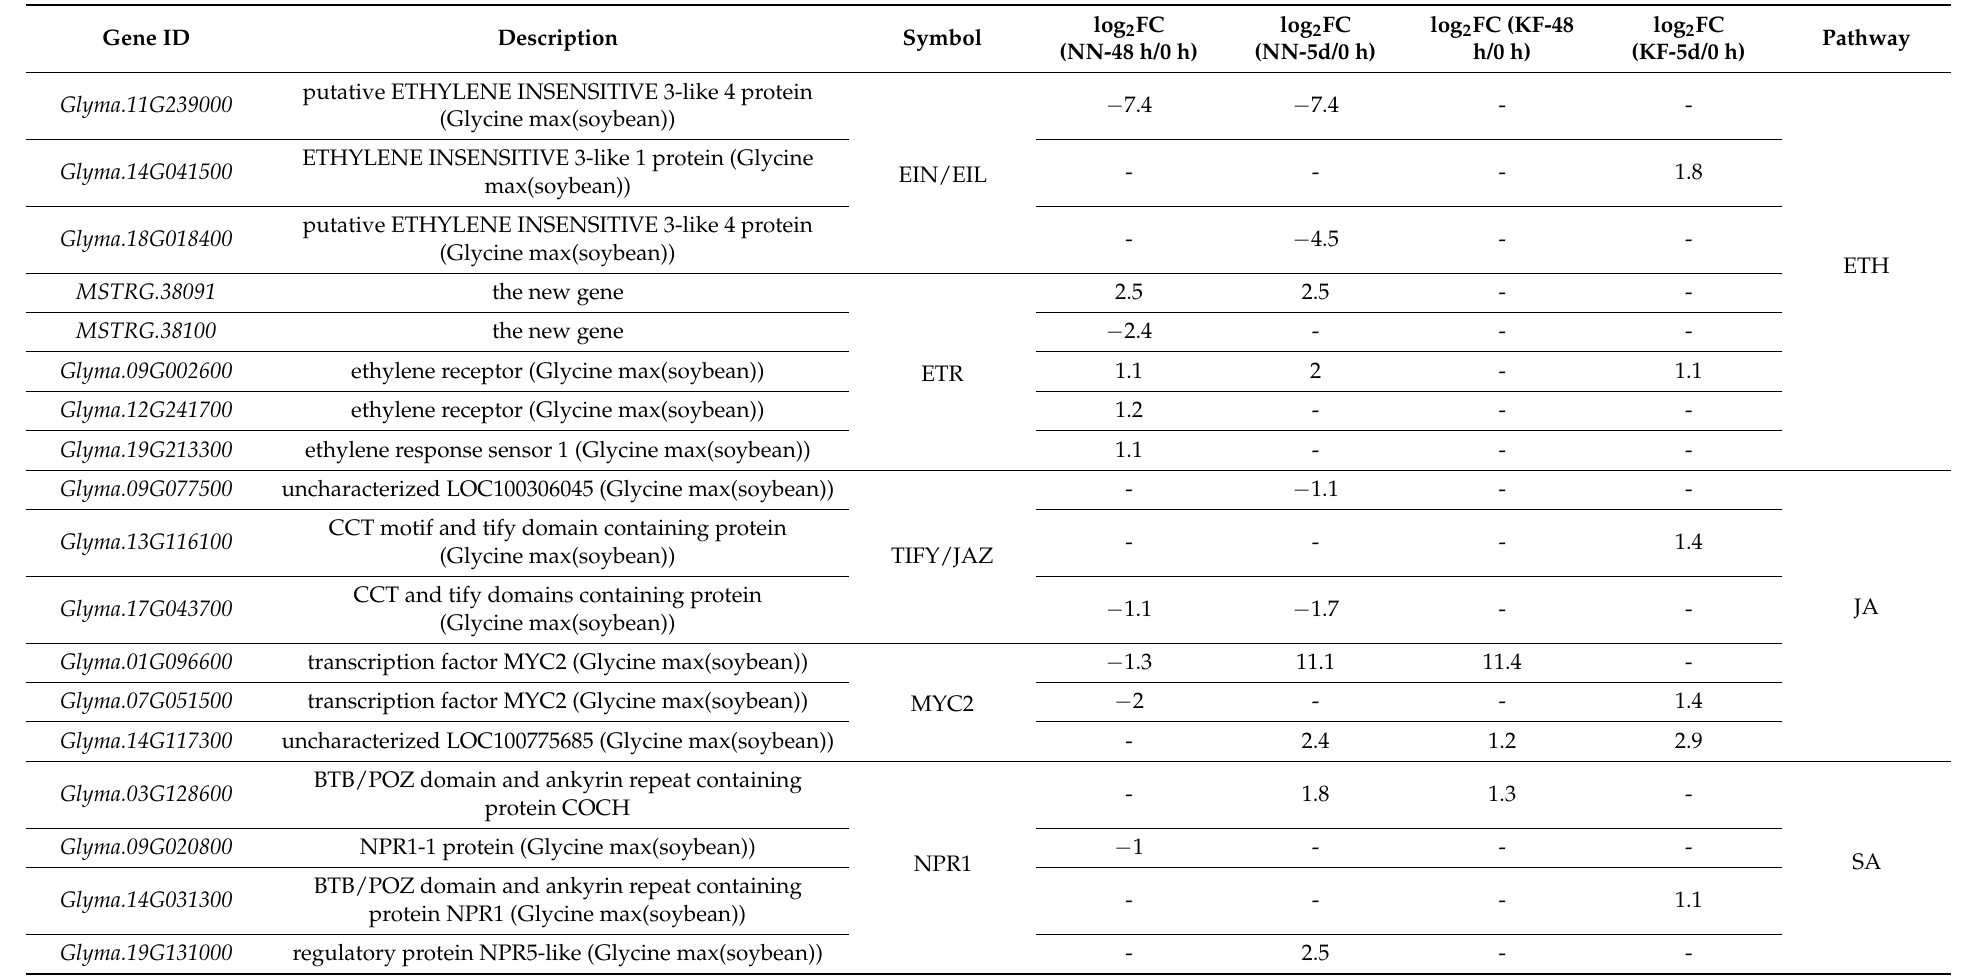
Table 1. DEGs involved three plant hormone signal pathways (SA, JA, and ETH) between susceptible and resistant varieties after SMV